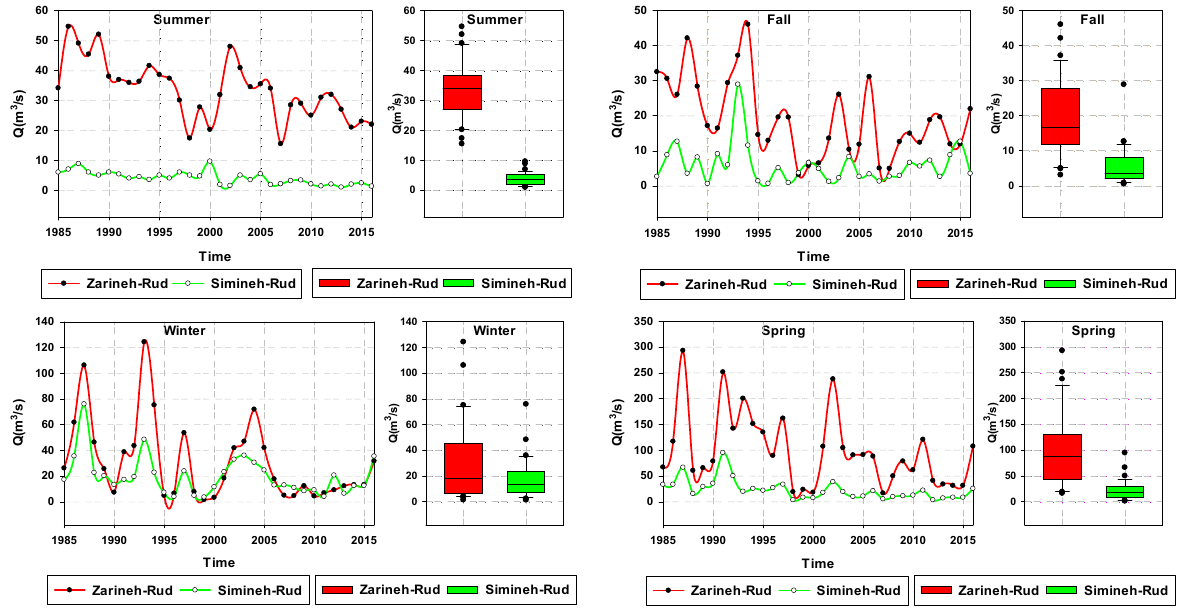
Figure 15. Seasonal hydrographs of the Zarineh-Roud and Simineh-Roud in the LU basin during 1985–2015.